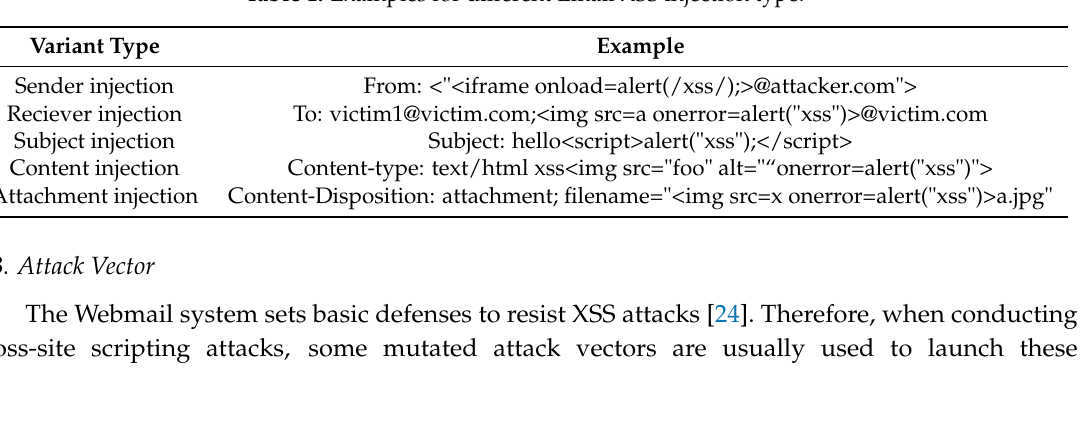
Table 1. Examples for different Email XSS injection